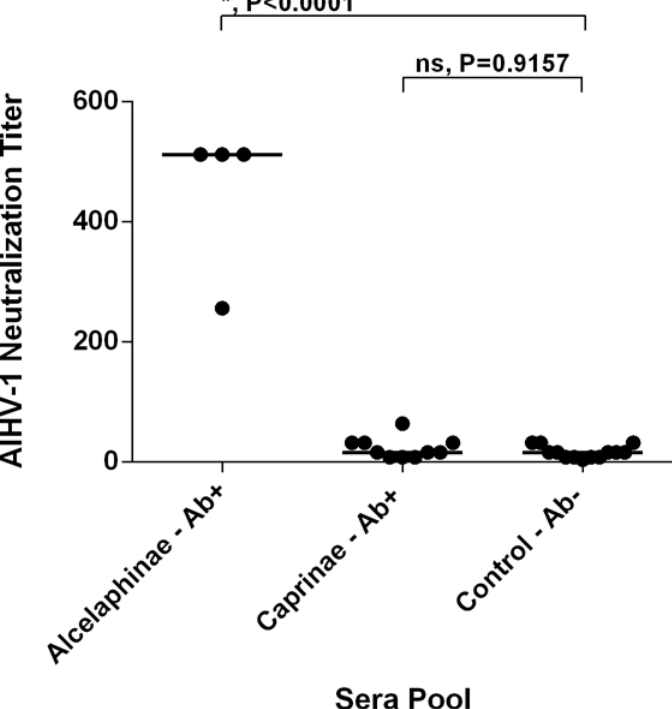
Fig 1. AlHV-1 neutralization by malignant catarrhal fever virus (MCFV) antibody-containing sera from animals in the subfamily Alcelaphinae. Virus neutralization titers are the reciprocal of the highest serum or plasma dilution which inhibited CPE in more than 50% of the wells at that dilution. Each circle represents a pool of sera. Lines indicate the mean titers in each group. * = Statistically significant difference. ns = not significant. Ab+ = MCFV Ab positive. Ab- = MCFV Ab